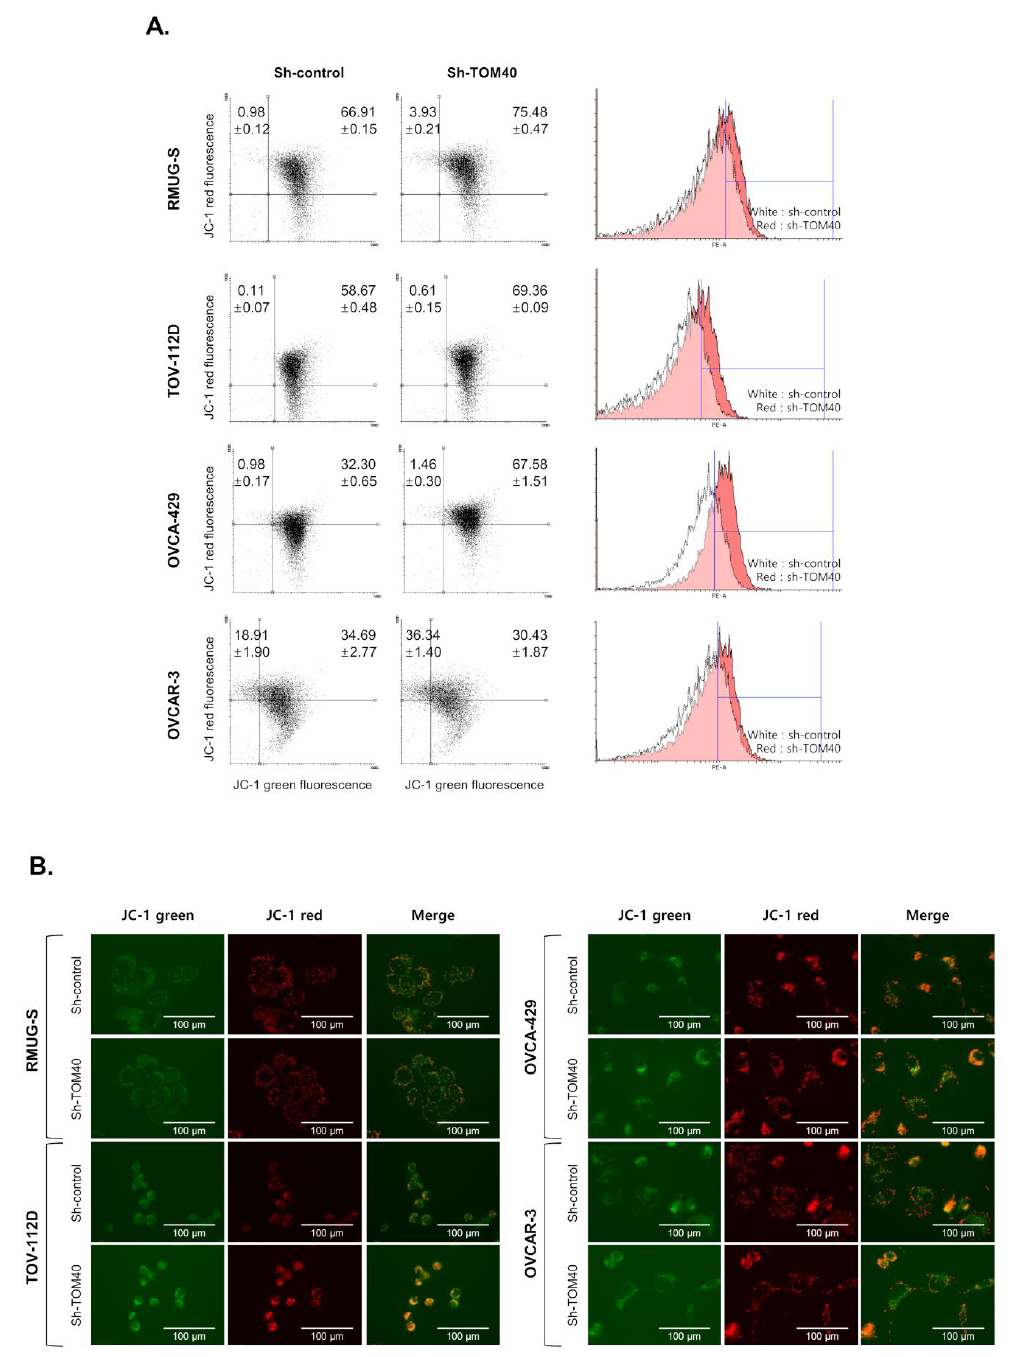
Figure 4. Cont Figure 4. Cont.